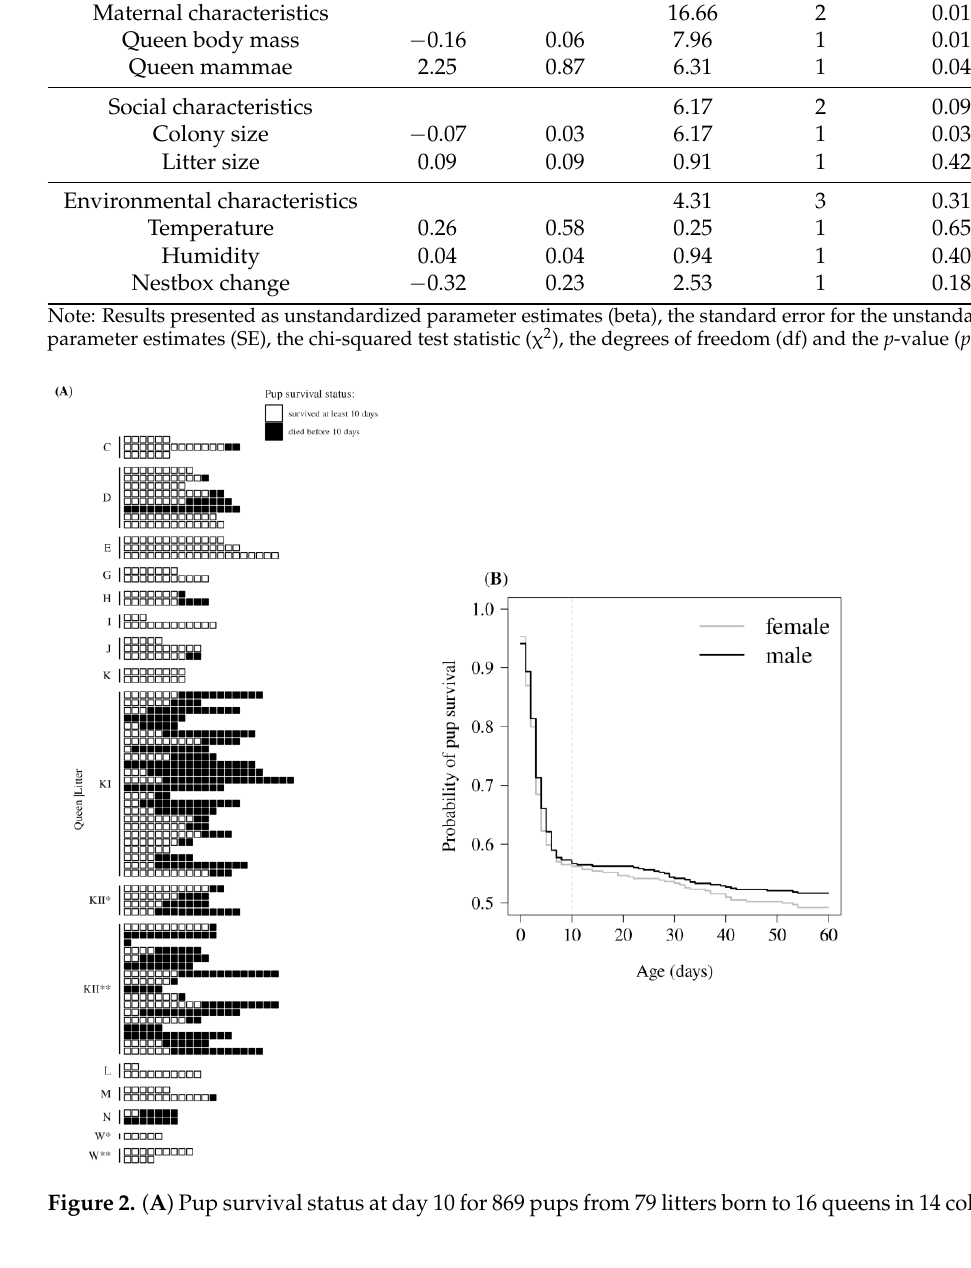
Figure 2. ( A ) Pup survival status at day 10 for 869 pups from 79 litters born to 16 queens in 14 colonies. Each row of squares represents one litter, with each square representing a pup. The color of the square refers to the survival status of the pup at day 10 as indicated in the legend. Litters